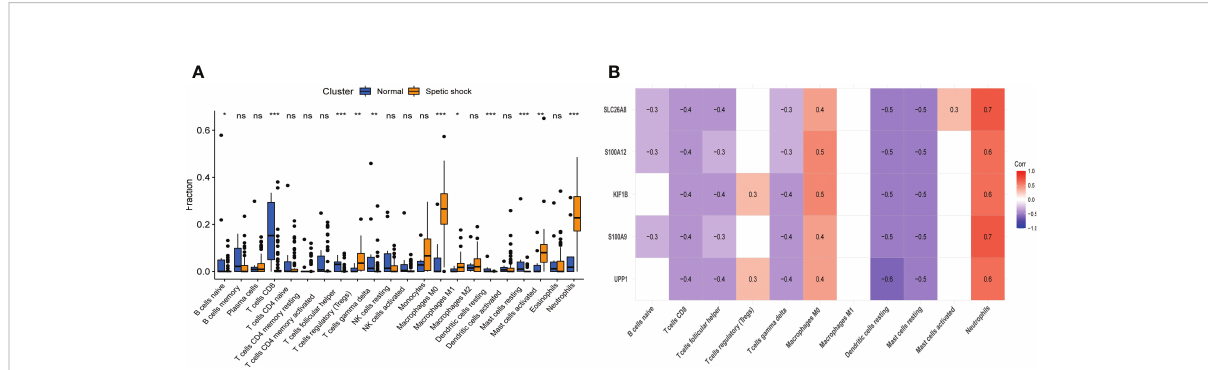
FIGURE 9 The immune cell in fi ltration association with signature genes. (A) The immune cell in fi ltration between the pediatric septic shock and healthy cohort. (B) The association between signature genes and signi fi cantly different immune cell in fi ltration. "ns" means P ≥ 0.01. *P < 0.01, **P < 0.001, and ***P <